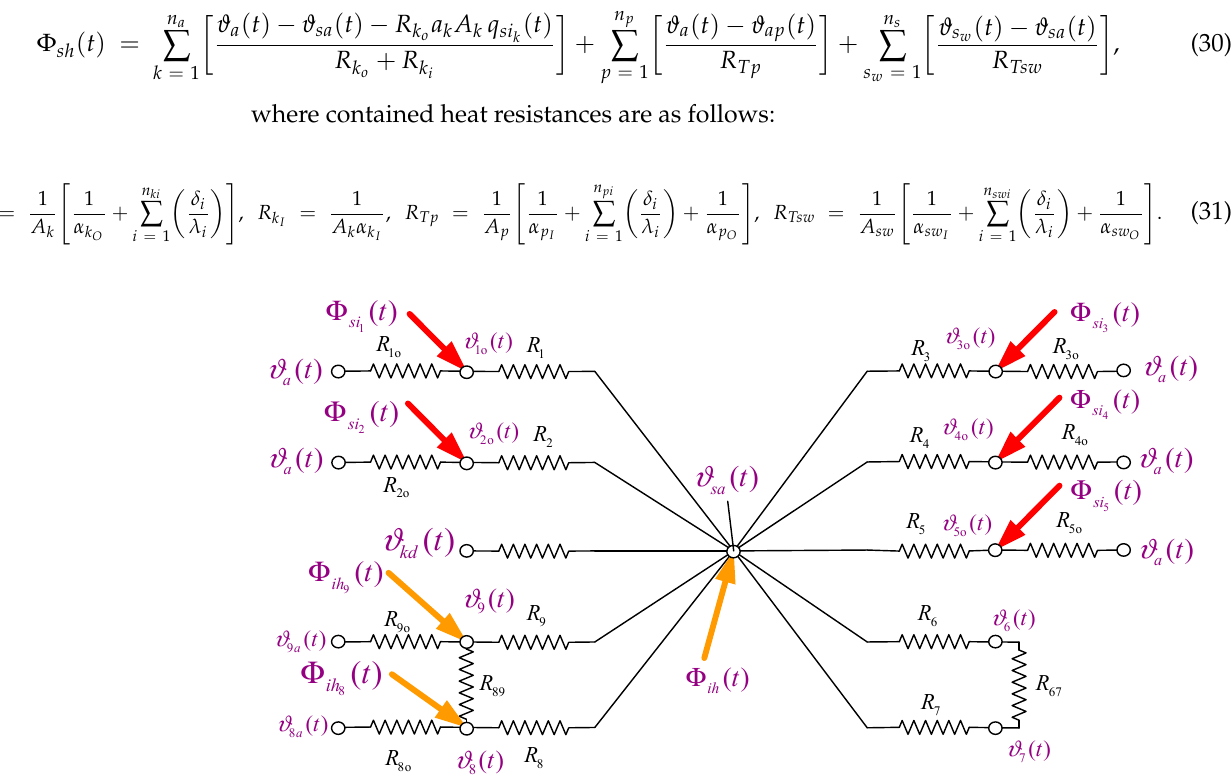
Figure 10. Simplified quasi-static thermal network of the accommodation.